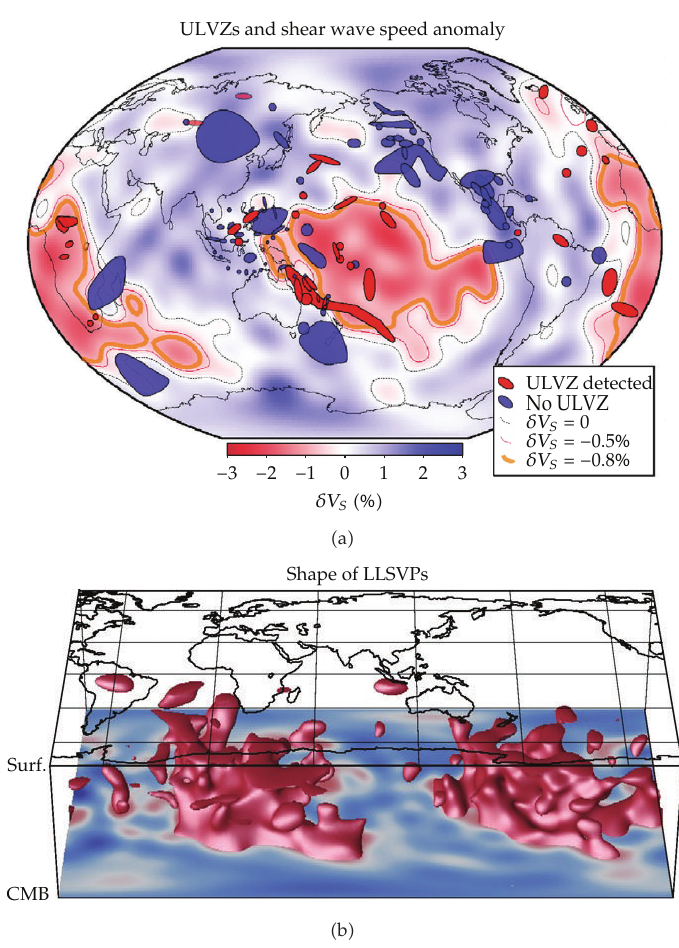
Figure 3: (cid:5) a (cid:6) Locations where ULVZ was detected superimposed on color map of shear wave speed anomaly (cid:5) δV S (cid:6) at CMB. (cid:5) b (cid:6) Isocontour of δV S showing the 3D structure of LLSVPs below Africa and the Pacific. Based on seismic model S20RTS (cid:3) 93, 94 (cid:4) . Reprinted from (cid:3) 86, 95 (cid:4) with permission from Elsevier.